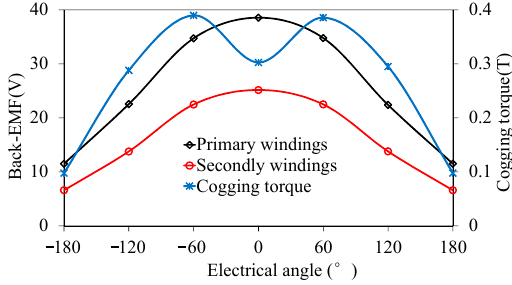
Figure 8. Back-EMF and cogging torque with different β .